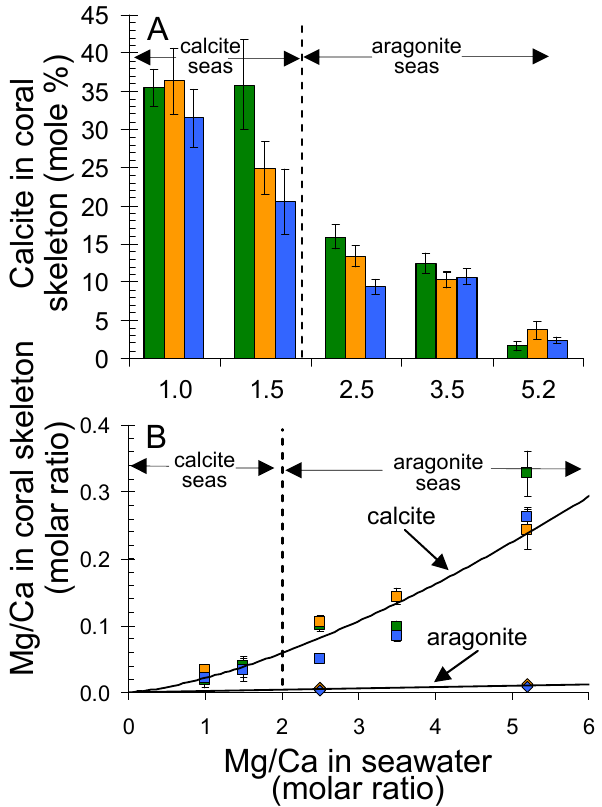
Fig. 18. Mineralogy and geochemistry of Acropora cervicornis , Montipora digitata , and Porites cylindrica reared in experimen- tal seawaters with Mg/Ca ratios ranging from 1.0 to 5.2 (from Ries et al., 2006). (A) Molar percentage of calcite in coral skeletons versus Mg/Ca ratio of experimental seawater. Green bars = A. cervicornis , orange bars = M. digitata , and blue bars = P. cylindrica . (B) Mg/Ca ratio of calcitic (green squares = A. cervicornis , orange squares = M. digitata , and blue squares = P. cylindrica ) and aragonitic (orange diamonds = M. digi tata, blue diamonds = P. cylindrica ) portions of coral skeleton. Solid black lines represent Mg fractionation curves for coral calcite (Mg/Ca C =0.02129Mg/Ca sw1 . 4628 , R 2 =0.9458, n =43) and coral aragonite (Mg/Ca C =0.002007Mg/Ca sw , R 2 =0.7537, n =43), calcu- lated using least squares regressions. Error bars correspond to in- strument error plus specimen variation. Mg/Ca < 2 = calcite seas; Mg/Ca > 2 = aragonite + high Mg calcite